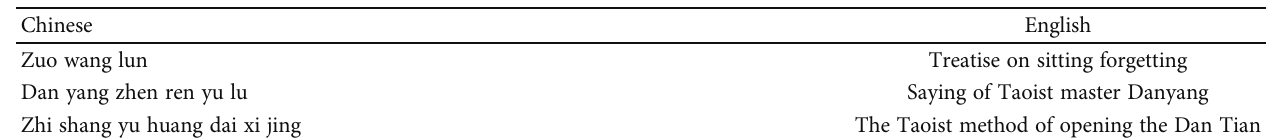
Table 2: Examples of Chinese and English sentences.